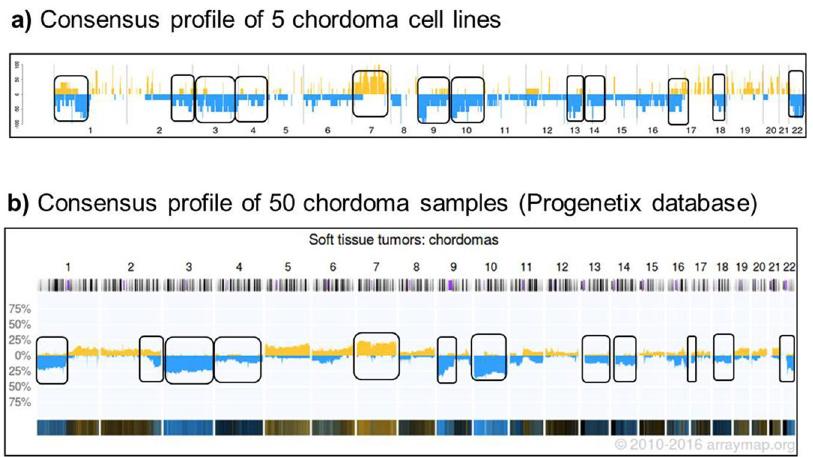
Figure 5. Comparison of chordoma cell lines vs . chordoma samples consensus profile.Comparison of the consensus profile obtained from all chordoma cell lines and the profile of the chordoma samples included in Progenetix database. ( a ) Consensus profile calculated using TSO coverage data from all the analyzed chordoma cell lines. Percentage of chromosomal aberration (gain or loss) obtained for each genomic interval in chordoma cell lines is reported on the y-axis of the plot. Regions of chromosomal gain are reported in yellow, while regions of chromosomal loss in blue. ( b ) Consensus profile of 50 chordoma clinical samples as obtained from Progenetix